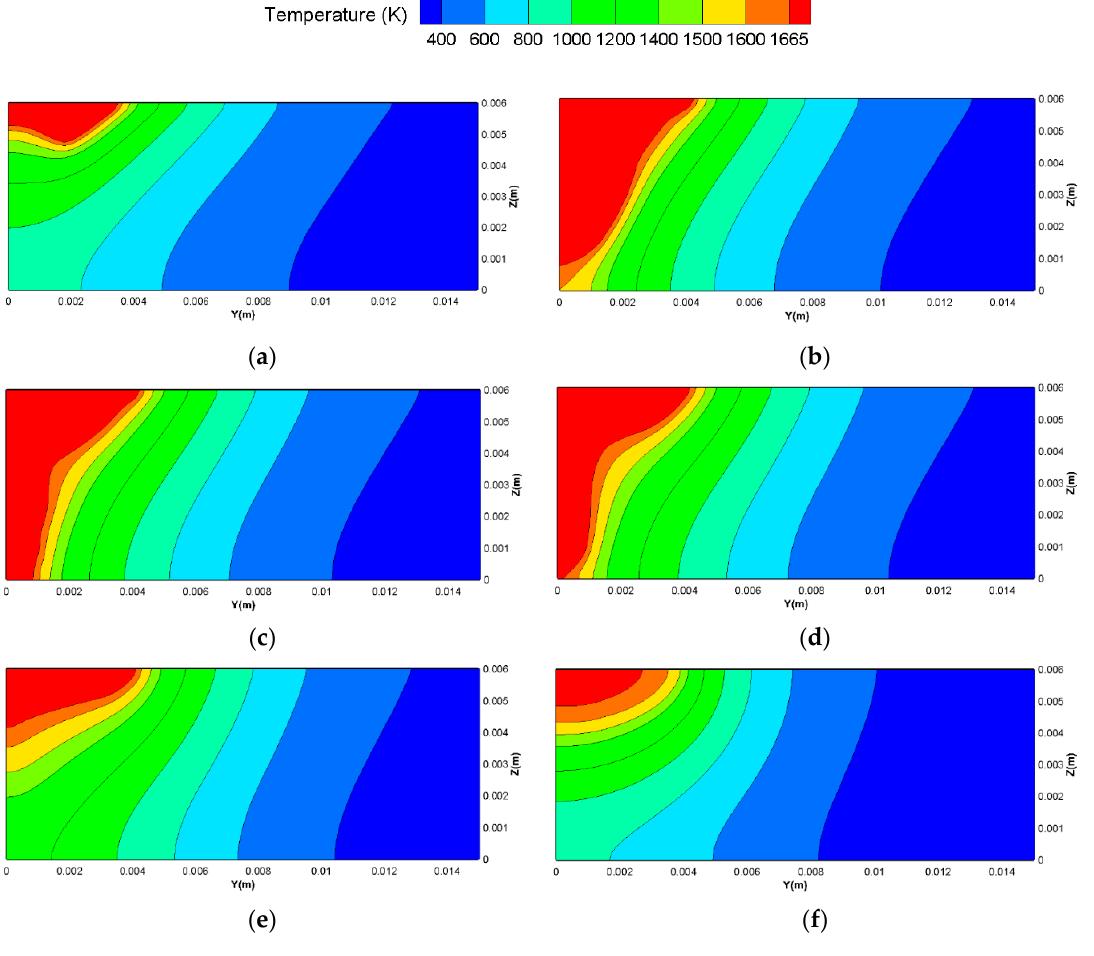
Figure 8. Weld pool and temperature field on the transverse cross-sections ( t = 3.2 s). ( a ) x = 1 mm; ( b )